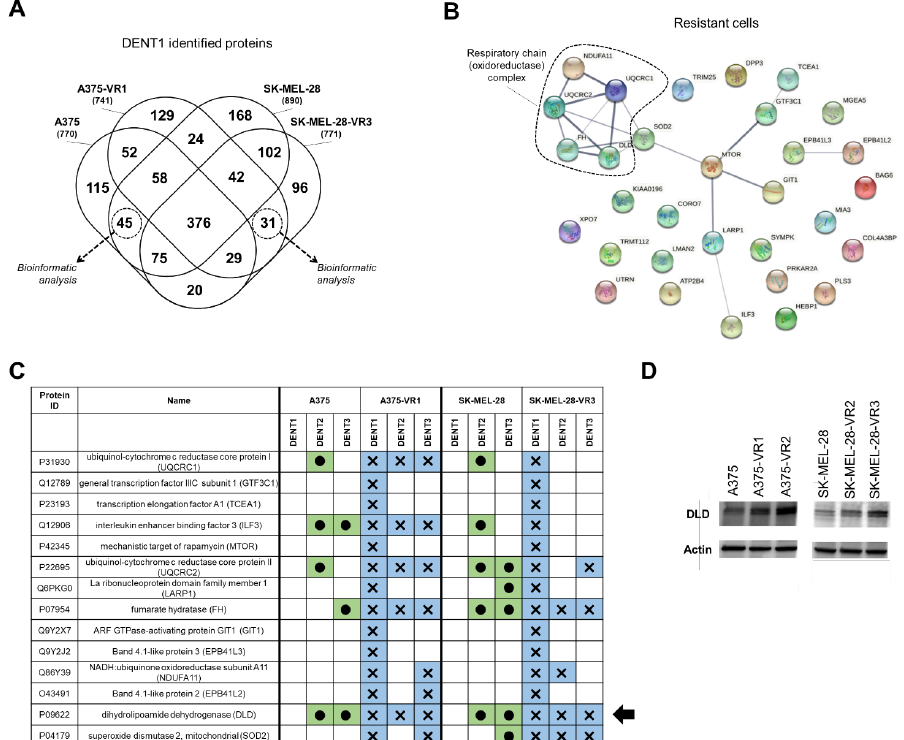
Figure 3. Proteomic analysis of DENT1 differentially expressed proteins. ( A ) Venn diagram representing the overlap in the identified proteins in each cell line. A total of 31 specific common proteins were identified in resistant cells. ( B ) The protein–protein interaction network of vemurafenib-resistant differentially expressed proteins as predicted by the STRING tool (version 11.5; http://string-db.org accessed on 20 July 2022). The links between proteins represent possible interactions (line thickness indicates the strength of association). The relevant pathway of respiratory chain complex was clustered. ( C ) Denaturation pattern of 14 proteins of resistant cells connected in the STRING network. This scheme depicts how these proteins are differently identified by the three denaturation protocols. Black arrow indicates DLD, as the unique protein showing the same identical denaturation pattern in parental (green boxes with circle) and resistant (blue boxes with cross) in both cell lines. ( D ) DLD expression validation by Western blot analysis (actin is used as internal standard).